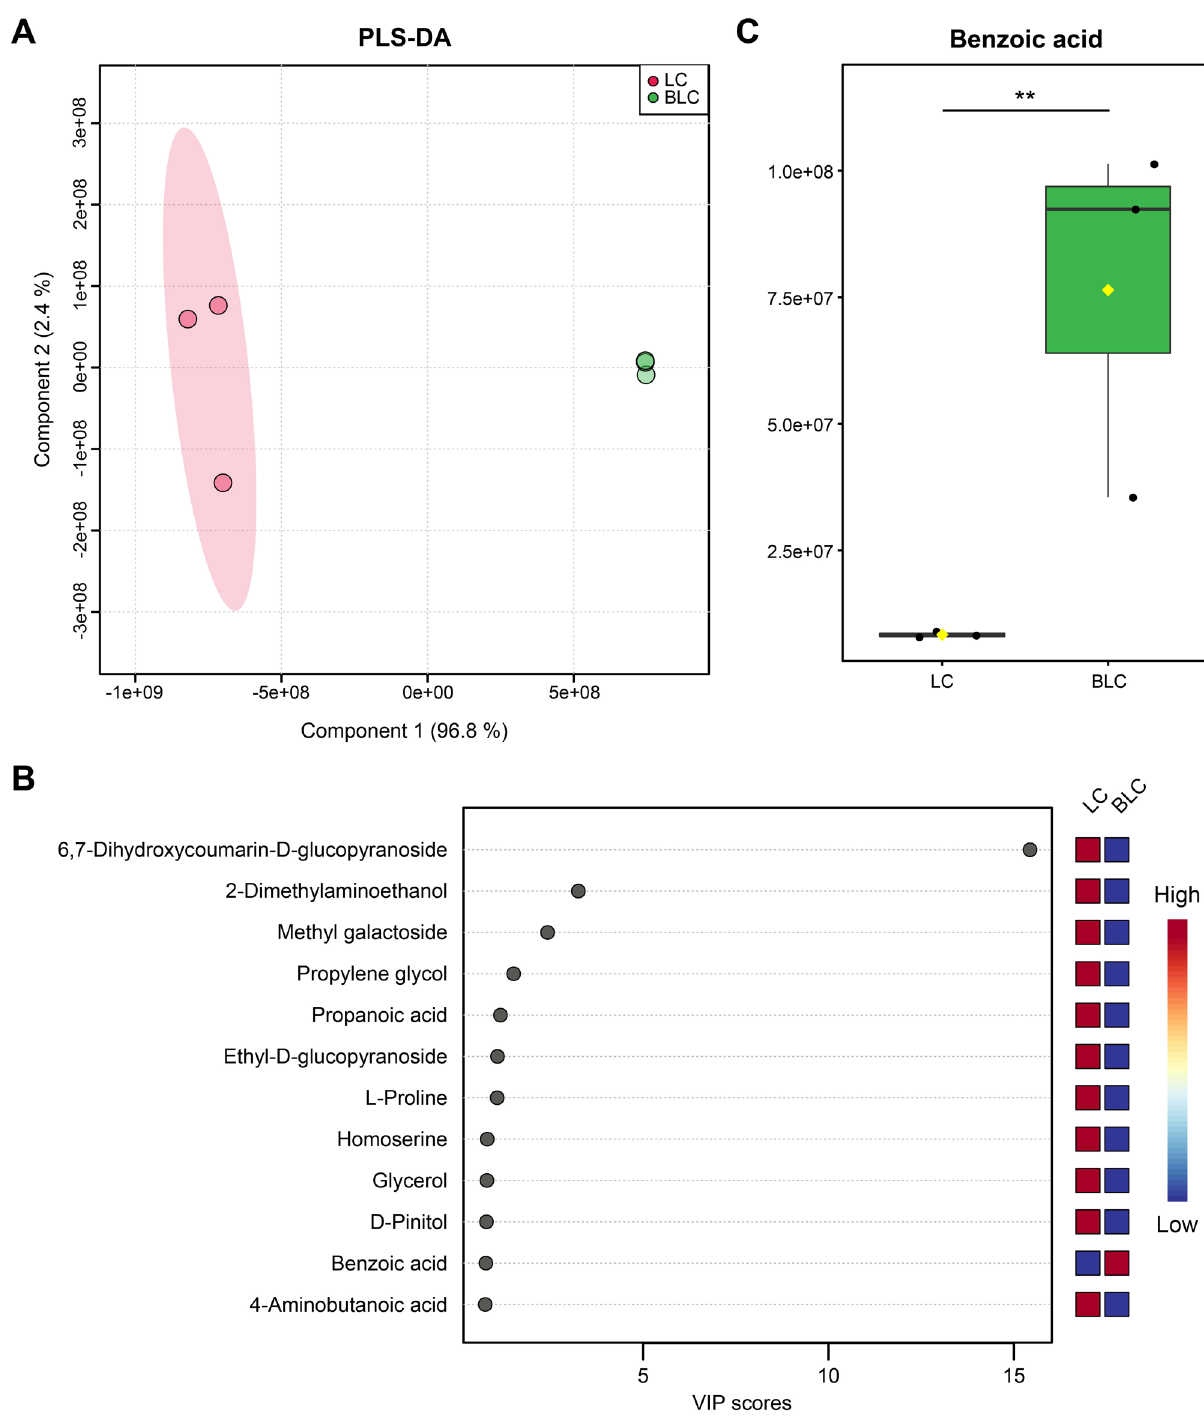
Figure 1. Compositional analysis of bioconverted product (BLC) and the seed extract (LC). ( A ) PLS-DA score plot using all features. ( B ) PLS-DA variable importance in projection (VIP) score plot. The features were selected with a VIP score > 0.7 based on the corresponding PLS-DA model. ( C ) Box plot of normalized peak abundances for benzoic